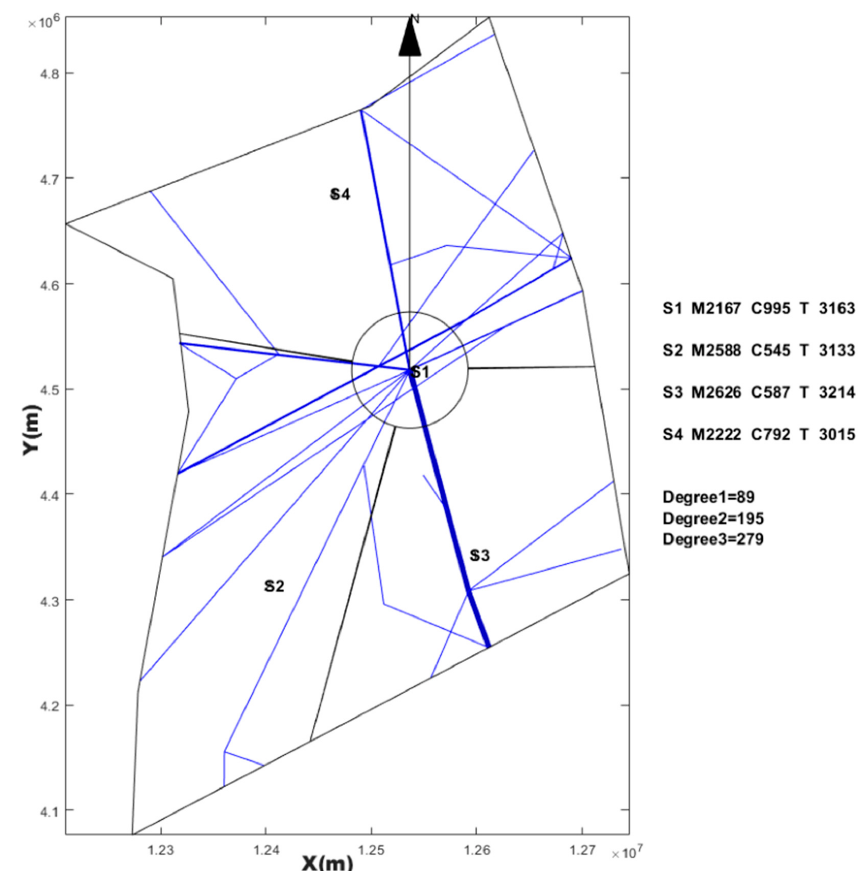
Figure 13. Hub-spoke optimizing partition using the MC-RC algorithm.